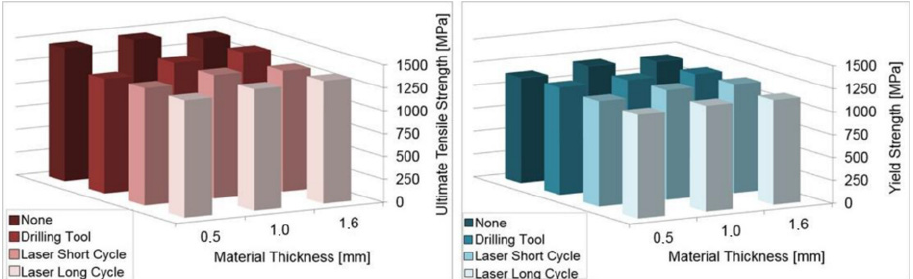
Figure 20. Comparison of results of uniaxial tensile testing at room temperature.